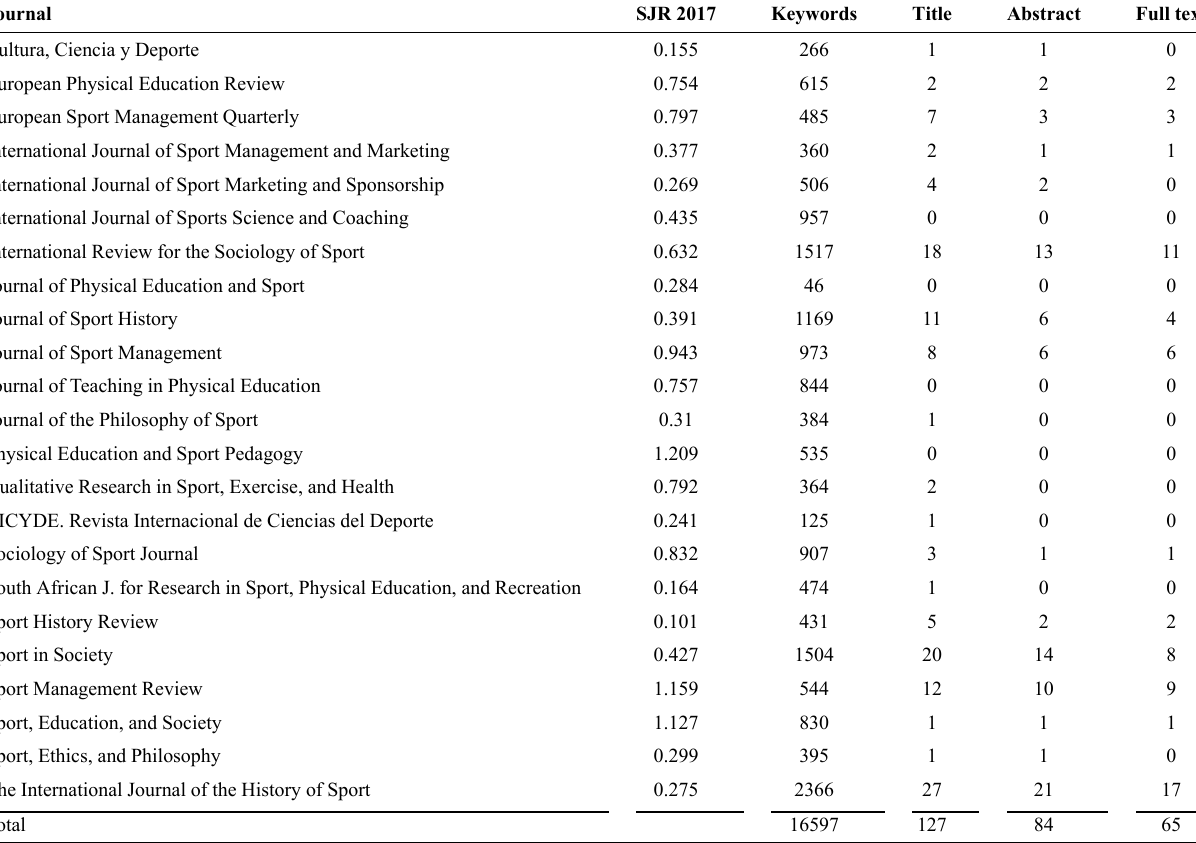
Table 1 - Journals used in the search for articles on the development of sport and number of studies found in each search phase.